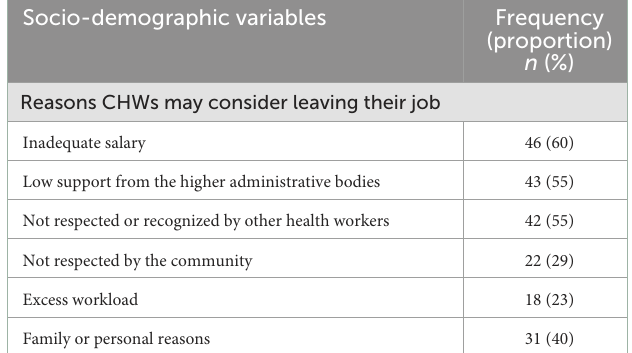
TABLE 1 Characteristics of participants (CHWs) ( n =